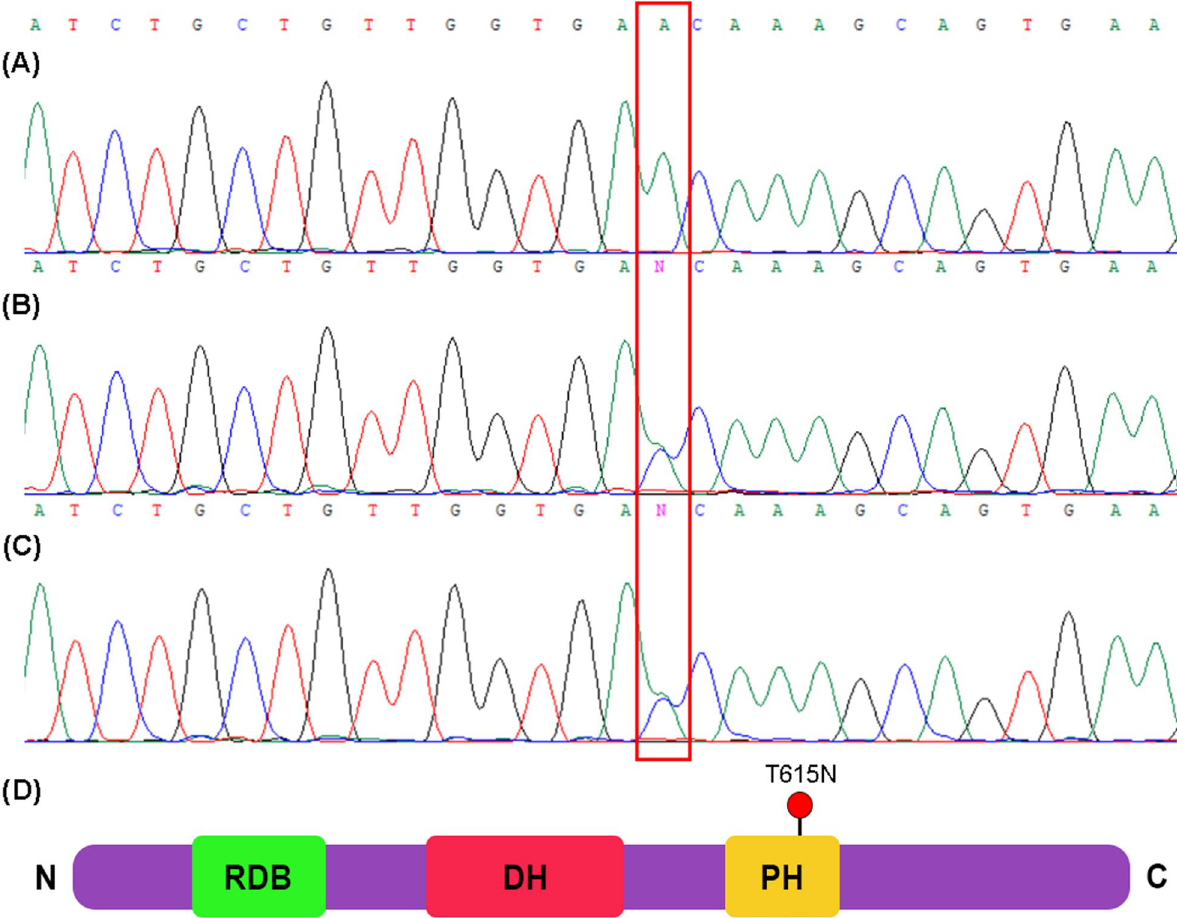
Fig. 2 Sanger sequencing confirming homozygous c.1844C > A mutation in the patient ( A ) and heterozygous mutation in his parents ( B , C ). D Diagram structure of PLEKHG5 protein. Schematic of PLEKHG5 protein shows the locations of the pathogenic variant in